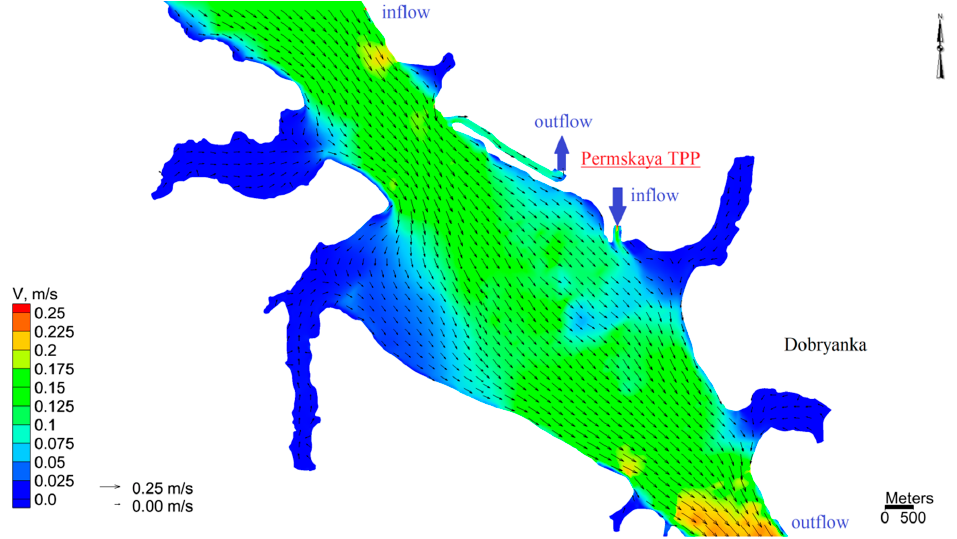
Figure 5. The velocity vector field in the vicinity of Dobryanka town at 4 days, 13 hours from the start of calculations, which corresponds to 1 hour of the day (stock flow, calm conditions).